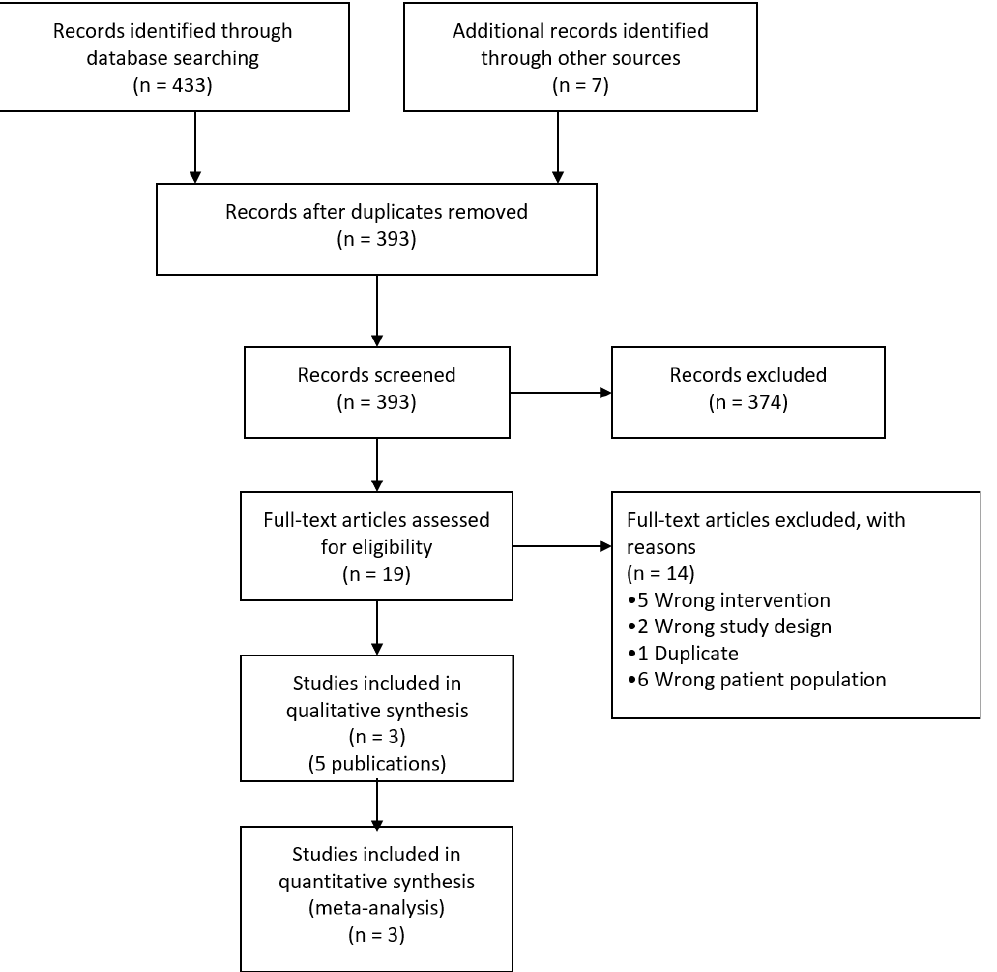
Figure 1. PRISMA diagram outlining the literature search. All searches were carried out on 24 June 2021.